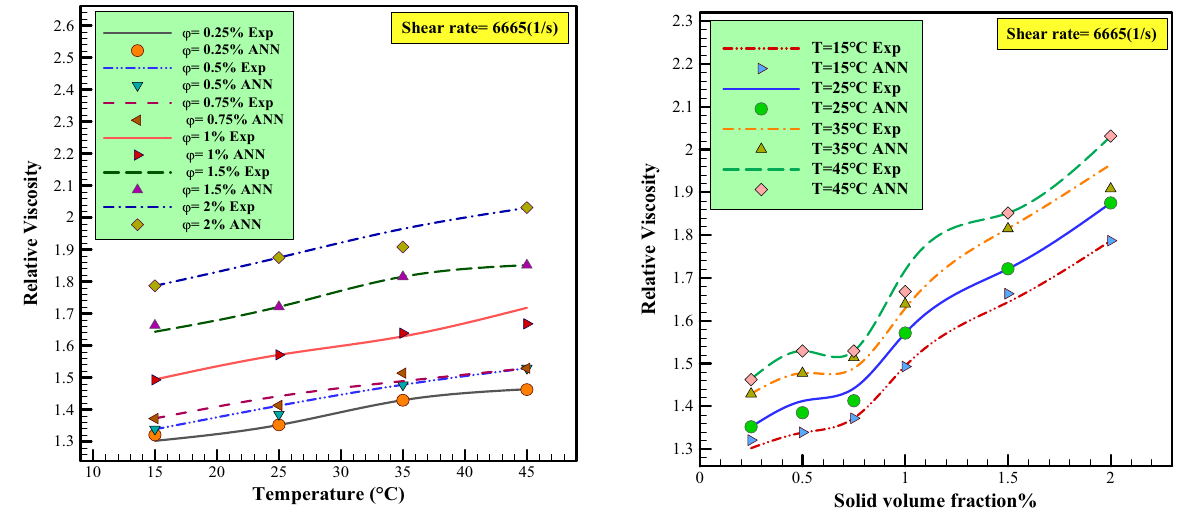
Figure 8. Comparison of relative viscosity data with ANN